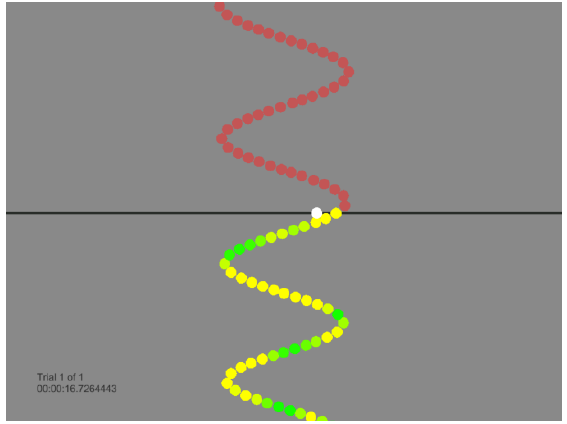
Figure 1. Motor acquisition tracing task design: participants attempted to trace a scrolling sinusoidal wave form composed of dots, using their right thumb. Continuous sinusoidal pattern waves moved vertically down the screen and participants attempted to copy each dot as it passed the horizontal line. The colour of the dots that comprised the sinusoidal wave ranged from green to represent good accuracy, and yellow to representing less accurate performance.